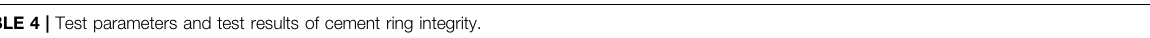
TABLE 4 | Test parameters and test results of cement ring integrity. ID